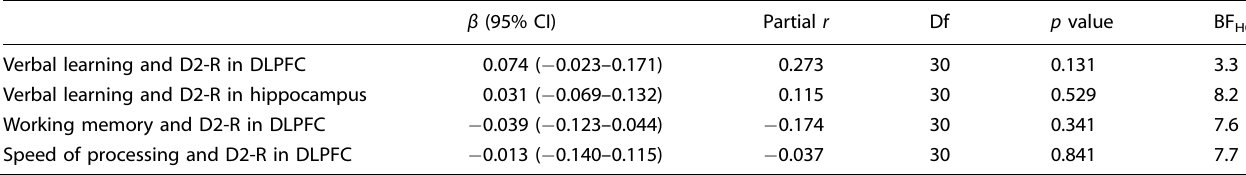
Table 3. Con fi rmatory analyses, the main effect of cognition.